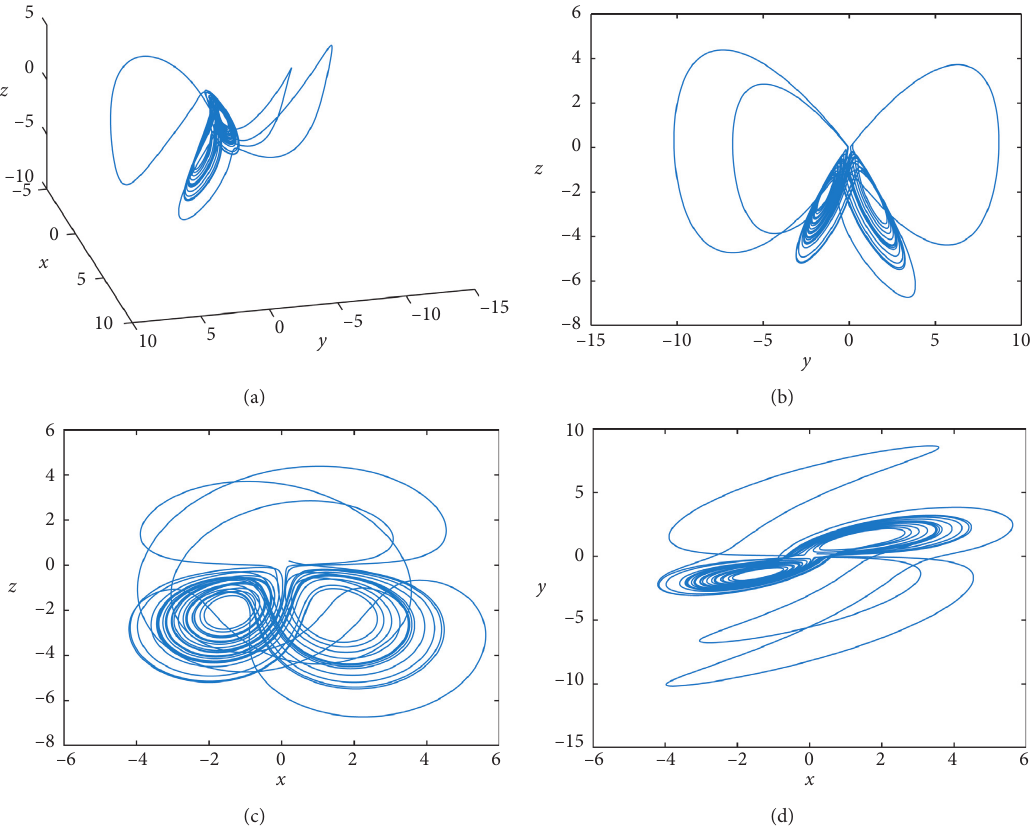
Figure 11: Phase portraits with incommensurate fractional system (42)–(44).